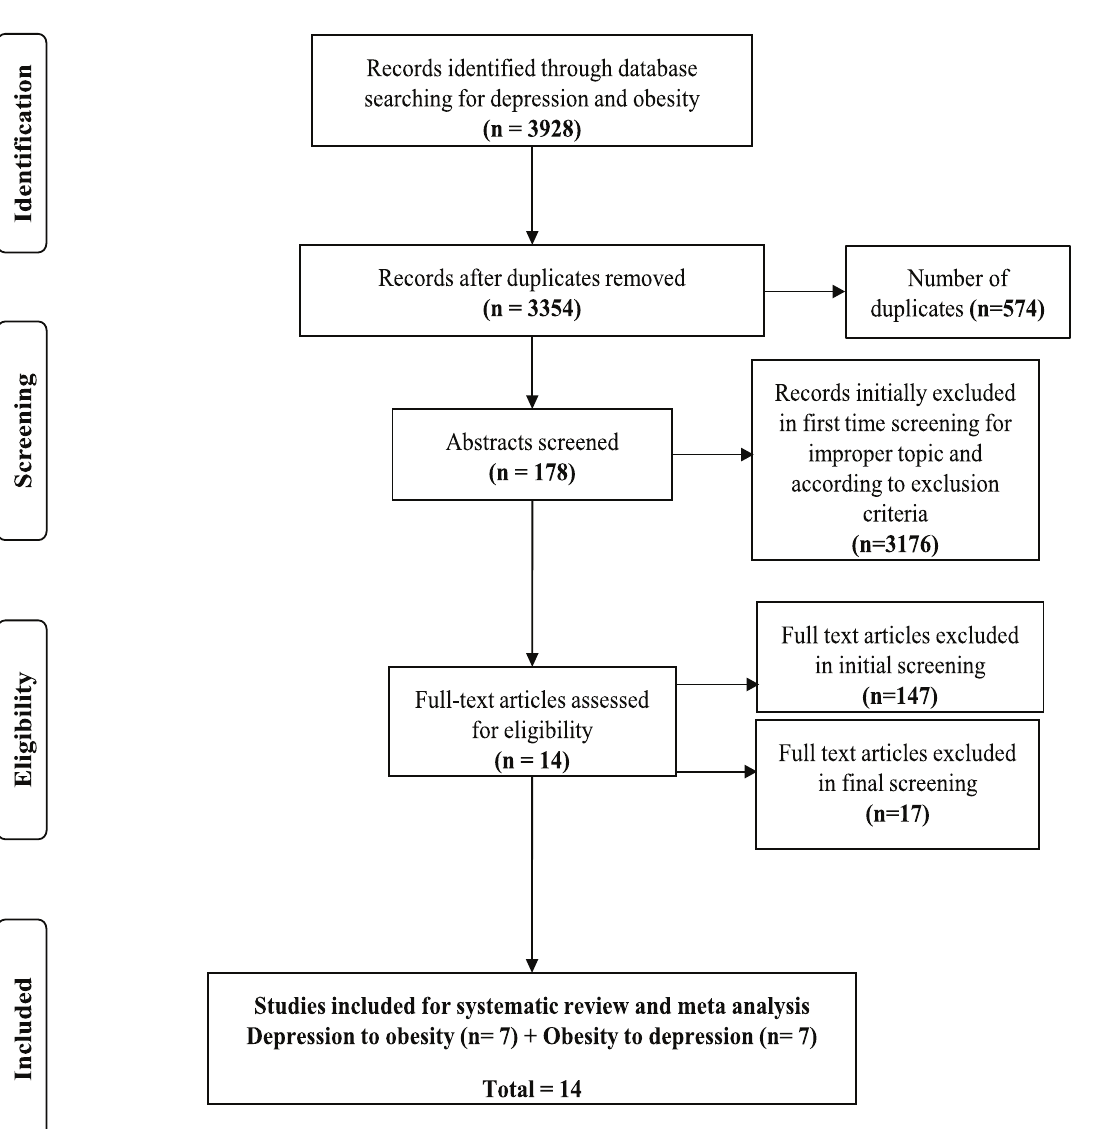
Fig 1. Flow diagram of the selection of articles through study. from: Moher D, Liberati A, Tetzlaff J, Altman DG, The PRISMA Group (2009). Preferred Reporting Items for Systematic Reviews and Meta-Analyses: The PRISMA Statement. PLoS Med 6(6): e1000097.